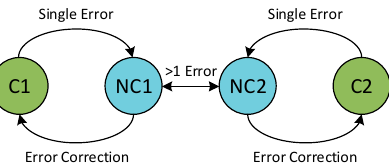
Figure 1. Illustration of distance-3 code and the relationship between codewords and non- codewords.